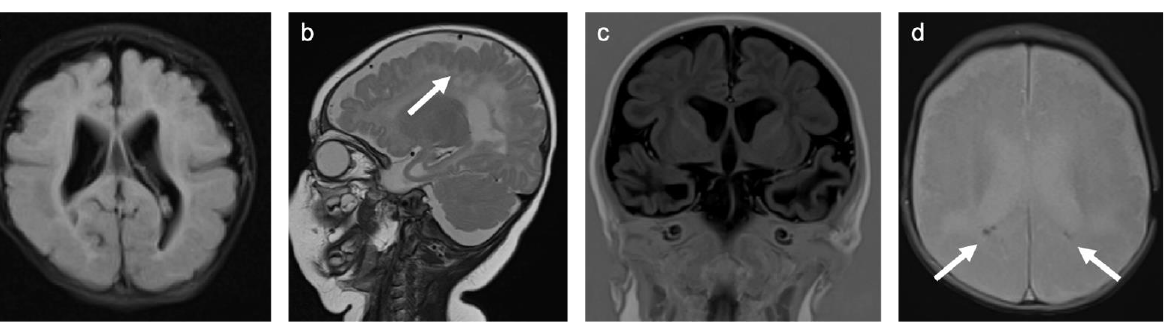
Figure 6. Representative case “Non - specific WMSAs”. FLAIR (a) and T2W (b) sequences. Fifteen- year-old girl presenting with a headache. MRI shows non-specific periventricular and subcortical WMSAs. Follow-up scan showed stable lesions ( a,b ). Patients in this group presented with WMSAs and clinical symptoms that were non-specific for the large number of disorders associated with such abnormalities.